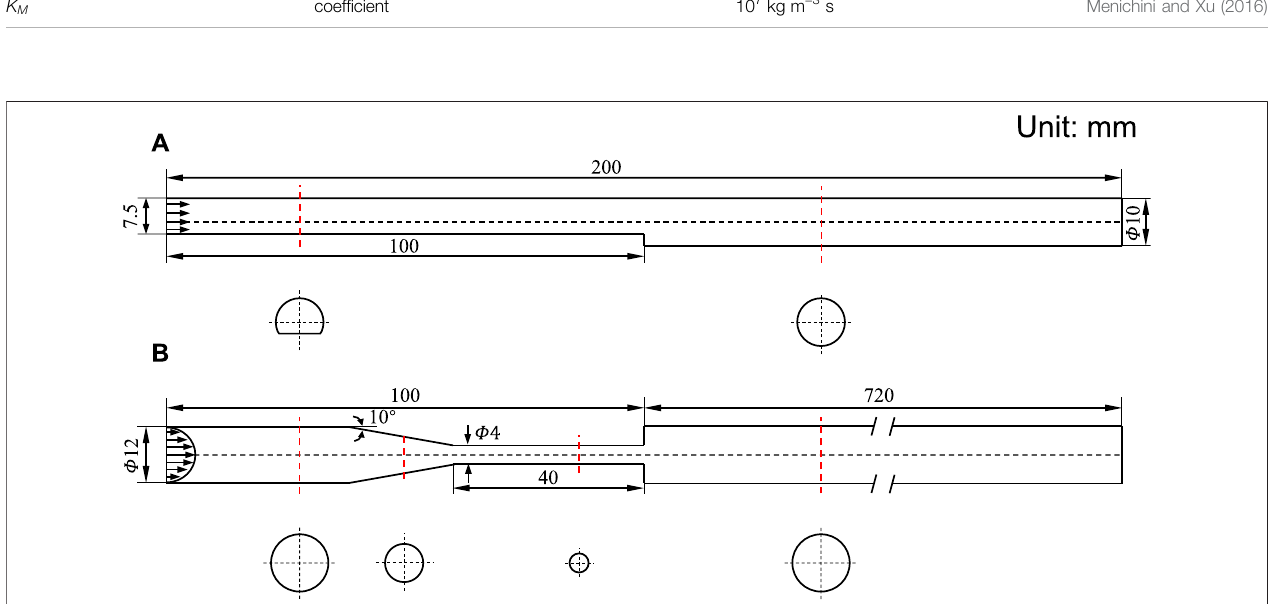
FIGURE 2 | Schematic diagram of 3D geometric models. (A) Backward-facing step model. (B) Benchmark nozzle of Food and Drug Administration. The inlet arrows indicate the velocity pro fi le. The red dotted line indicates the cross-section position, and the cross-section shape is below.